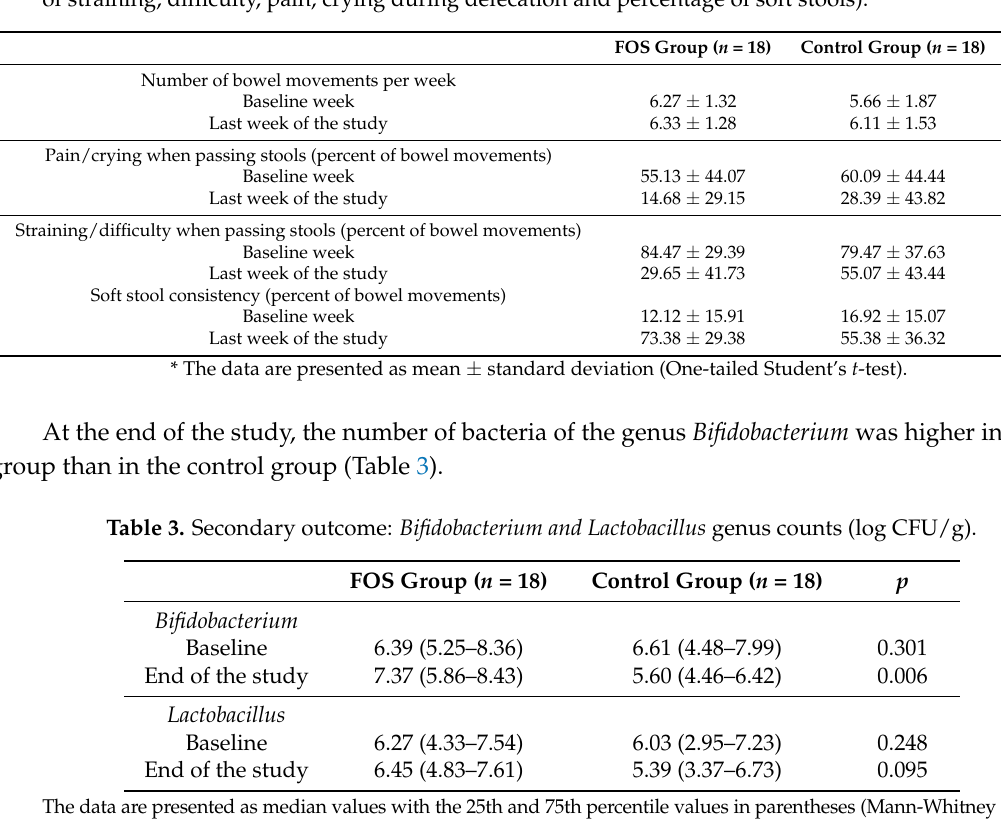
Table 2. Clinical secondary outcomes at baseline and at the end of the study (stool frequency, percentage of straining, difficulty, pain, crying during defecation and percentage of soft stools).